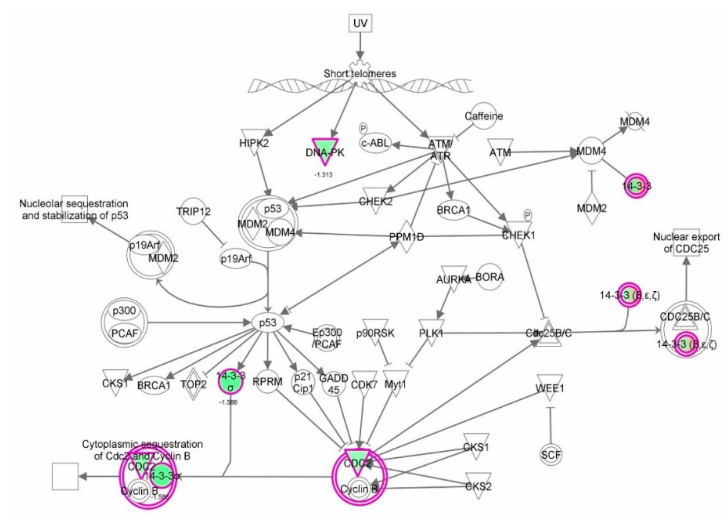
Figure 27. G 2 /M DNA damage check point signaling pathway was regulated by vancomycin in HK-2 cells. HK-2 cells were treated with 50 µ g/mL vancomycin for 24 h and the protein samples were subject to quantitative proteomic analysis. Green indicates a down-regulation. The intensity of greencolor indicates the degree of down-regulation. Solid arrow indicates direct